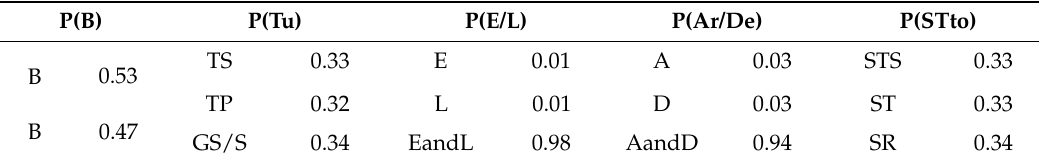
Table 2. Marginal probability of DBN.